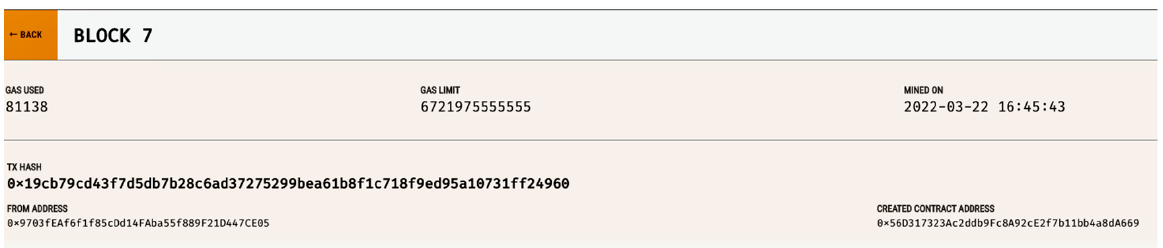
Figure 8. Transaction for company creation in Ganache.